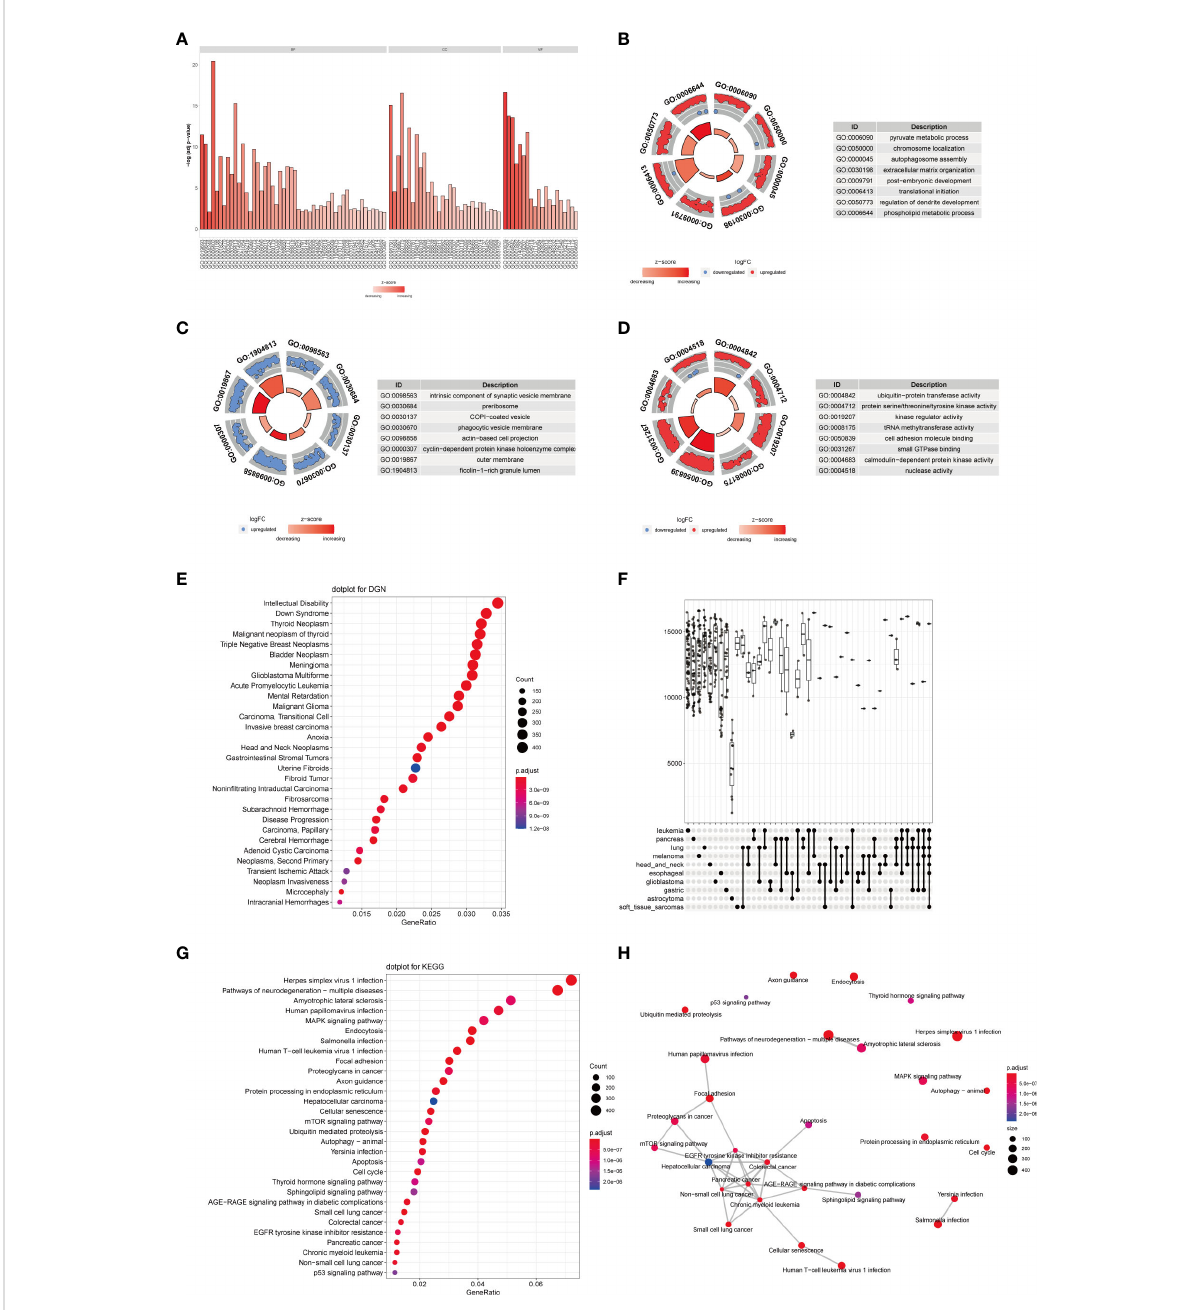
FIGURE 4 TRAF3IP3-related differential expression gene enrichment analysis. (A – D) GO function enrichment analysis using the differentially expressed genes between the TRAF3IP3-high expression group and TRAF3IP3-low expression group, displaying BP, CC, MF. (E) DGN enrichment analysis. (F) NCG enrichment analysis. (G) KEGG enrichment analysis. (H) The connection between the enriched KEGG